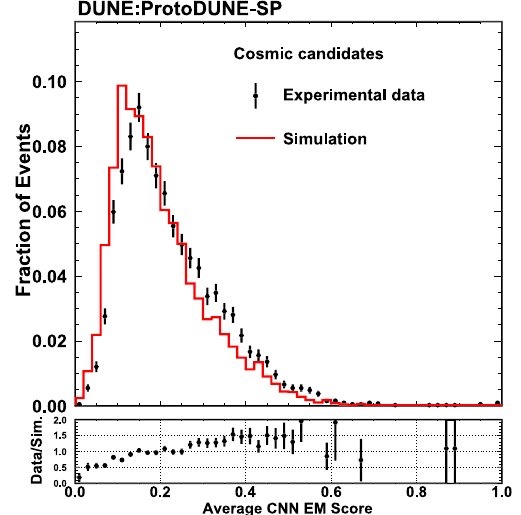
Fig. 10 The average CNN shower classifier scores for cosmic-ray muons. The error bars on the experimental data are statistical